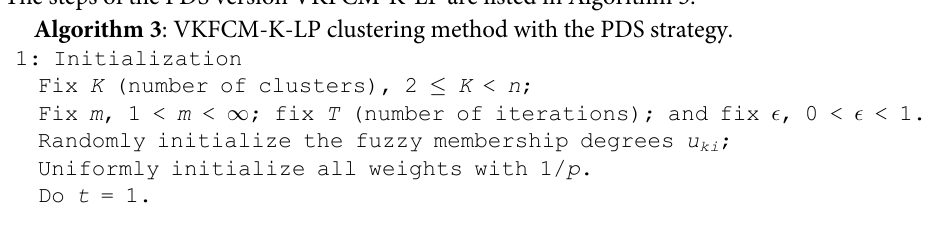
Algorithm 3 : VKFCM-K-LP clustering method with the PDS